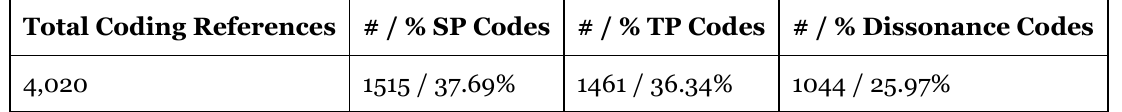
Social, Teaching, and Dissonance